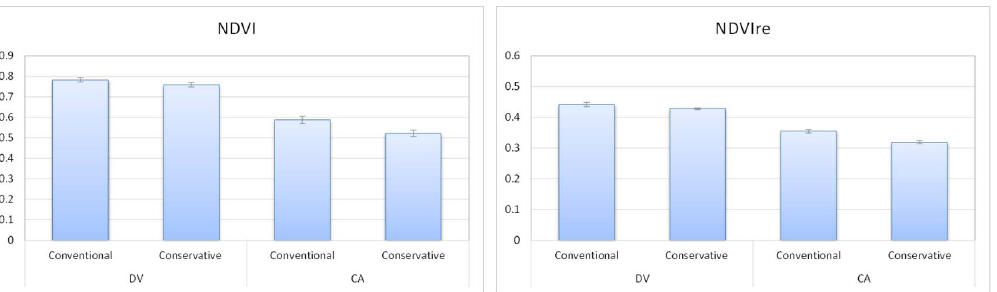
Figure 13. Comparison of vegetation indices for conventional (deep tillage) and conservative practices (no tillage at the DV site and soil ripping at the CA site).